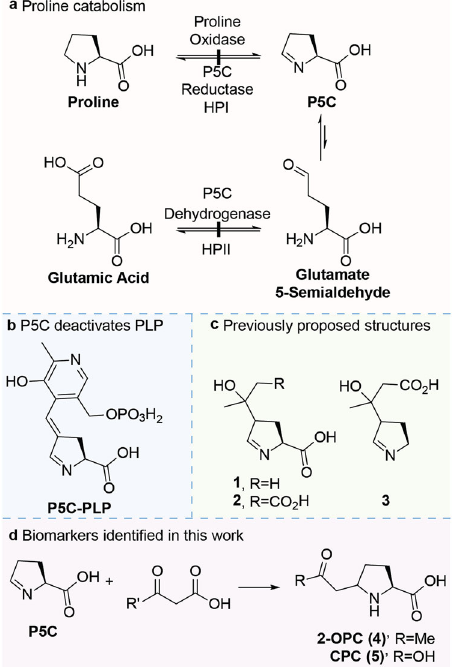
Fig. 1 The de fi cient metabolic conversion of P5C to glutamic acid leads to aberrant reactivity. a De fi ciency of P5C dehydrogenase leads to the accumulation of P5C and glutamate 5-semialdehyde. b Reaction of P5C with PLP leads to the deactivation of the latter. c Previously proposed biomarkers for HPII 6 . d Biomarkers of P5C with 1,3-dicarbonyl compounds were identi fi ed in this study.